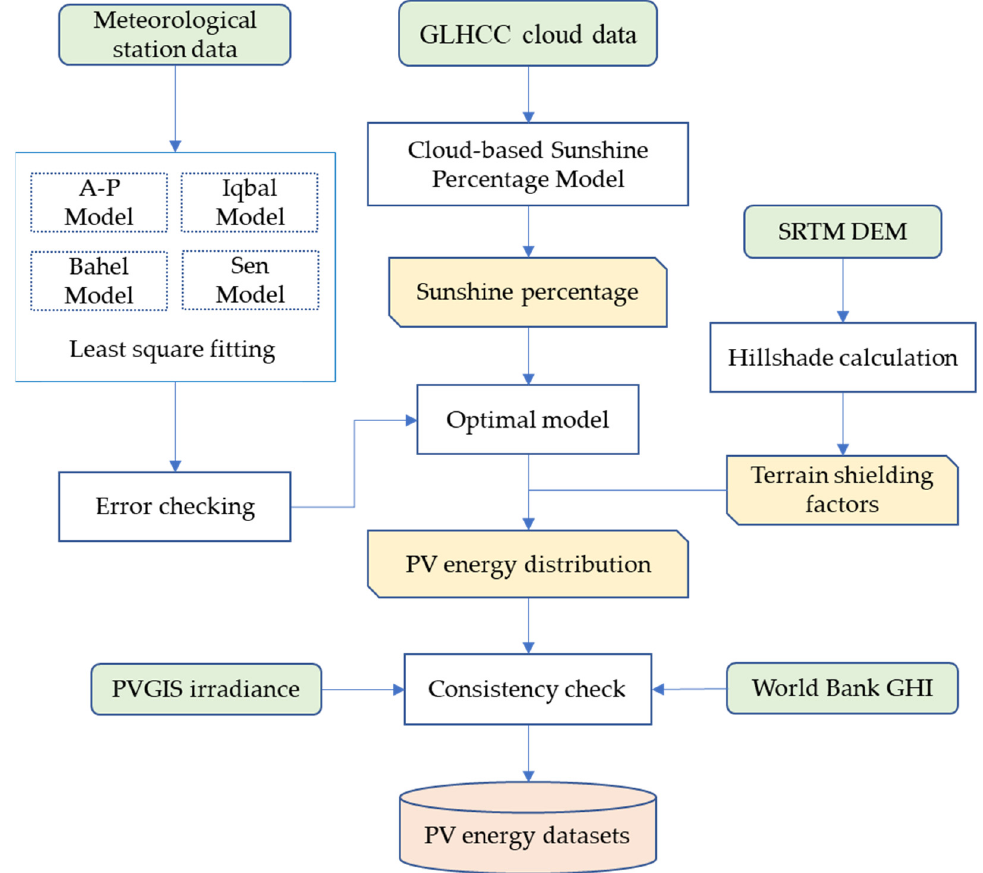
Figure 2. Technical flowchart of the cloud-based solar radiation estimation model.